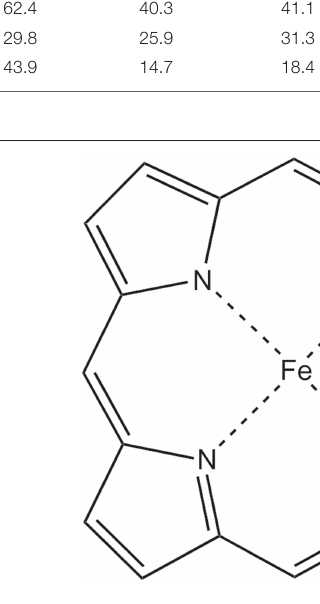
FIGURE 4 | The Fe(II)–porphyrin